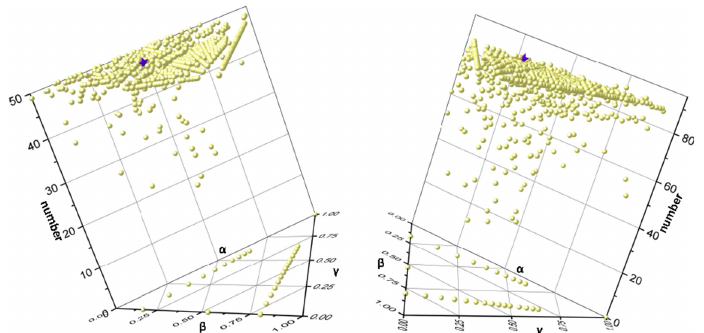
Fig 3. The 3-D distribution of seed genes in top 50 (left) and top 100 (right) of the ranking gene list against all parameter combinations. The three sides of the triangle coordinate system represent the three parameters, respectively. The perpendicular axis of the triangular coordinate system represents the number of seed genes. The purple five-pointed star and yellow ball present the optimal parameter combination and all other parameter